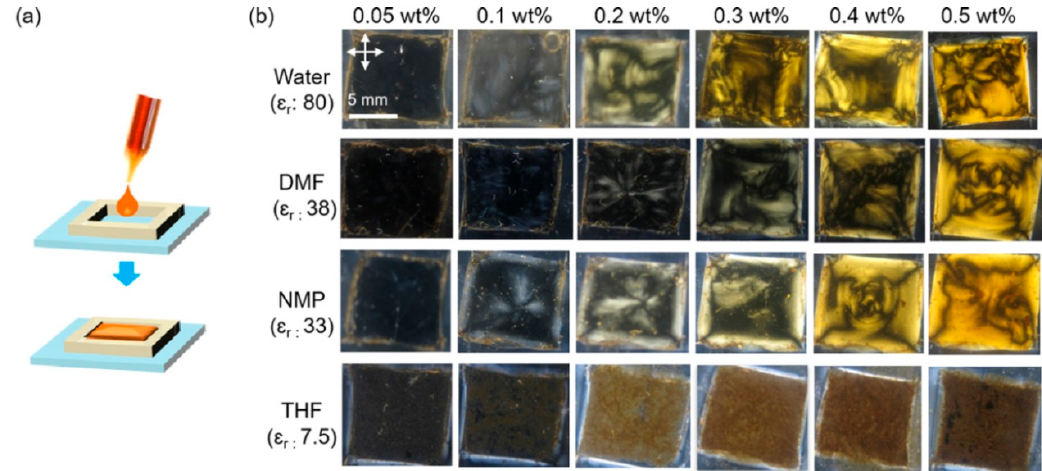
Figure 7. Polarizing optical photographs of dispersions of graphene oxide in different solvents and at different concentrations are shown ( b ). In tetrahydrofuran (THF), GO tends to flocculate, meaning spontaneous orientational order does not occur. The apparatus used to contain the dispersions for observation is shown in part ( a ). Reprinted from Ahmad et al. [42], with the permission of AIP Publishing.